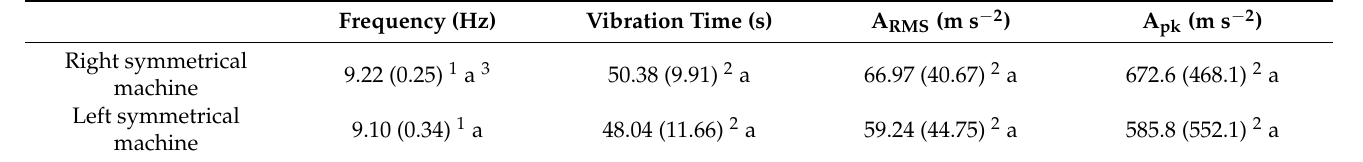
Table 3. Vibrationparametervaluesforthetwosymmetricalmachinesofwhichtheprototypeiscomposed.